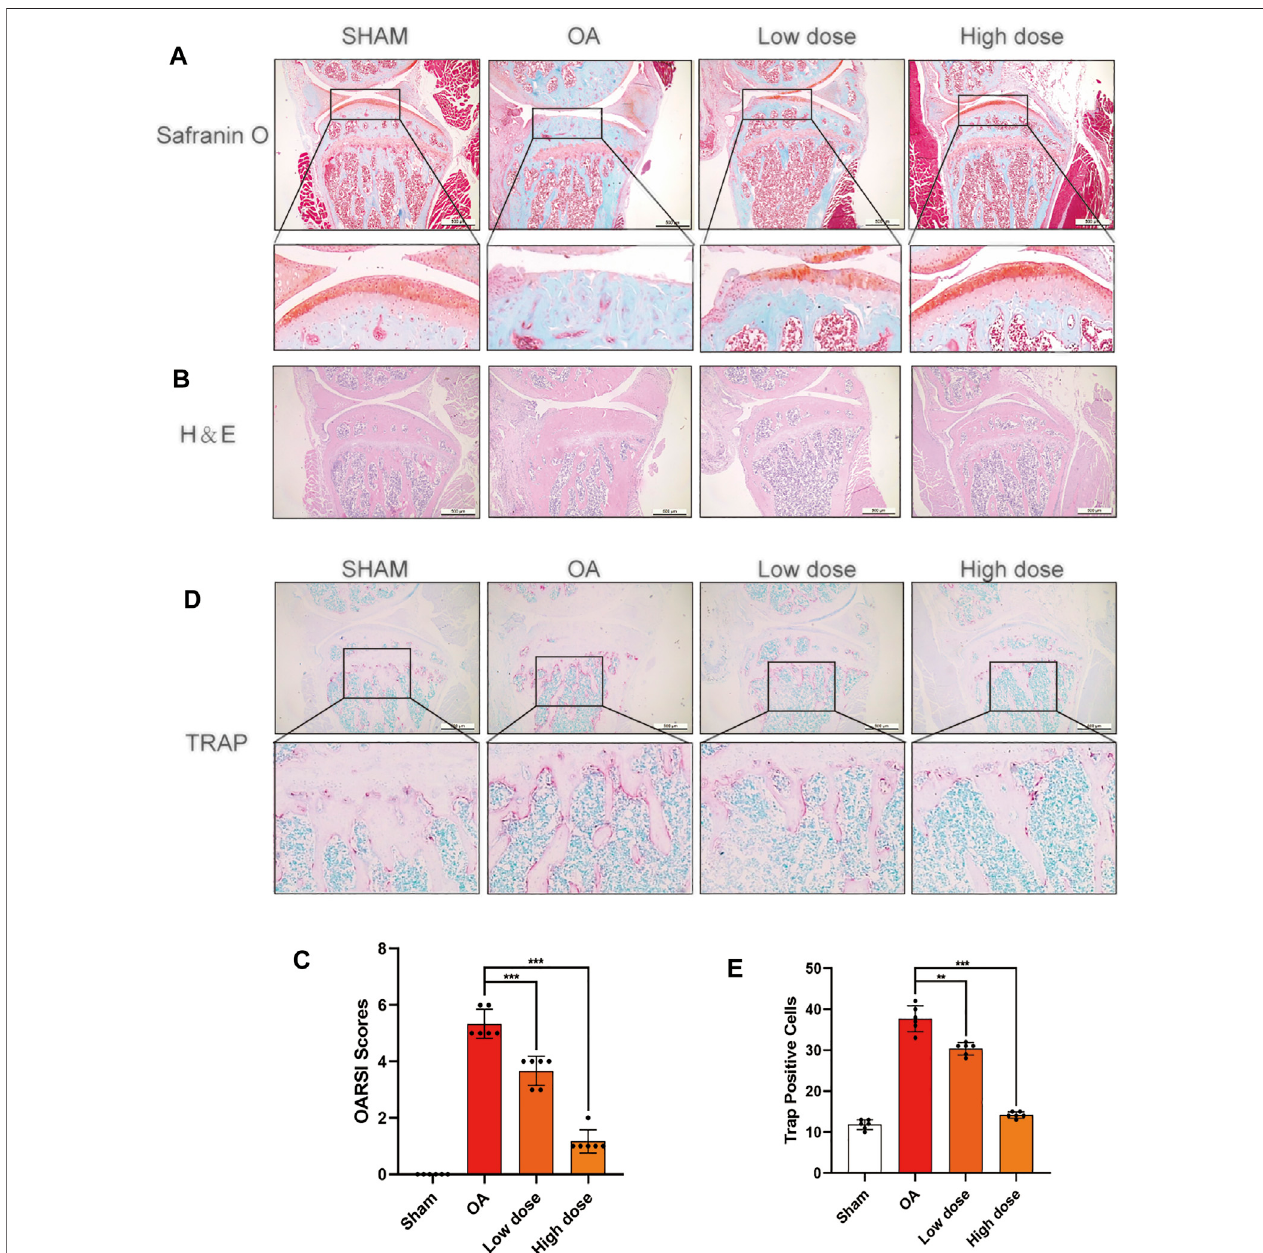
FIGURE 7| SSD treatment delayed the progression of cartilage destruction in OAmiceand decreased the osteoclasts in the knee joints ’ subchondralbone. (A,B) The S-O staining and H&E staining images of the right knee articular cartilage of 8-week-old male mice. SSD protected the mouse ’ s right knee articular cartilage from damage. (C) The knee joint damage of each group was evaluated according to Osteoarthritis Research Society International (OARSI) scores. (D) The images of subchondral bone TRAP staining in male mice at 8 weeks. The activity of osteoclasts was weakened in the subchondral bone of mice right joints after SSD treatment. (E) The TRAP-positive cells were measured in the subchondral bone of each group using ImageJ. Mean ± SD was applied with all data. There were 6 randomly assigned male mice in each group. *** p < 0.001, ** p < 0.01, * p < 0.05.